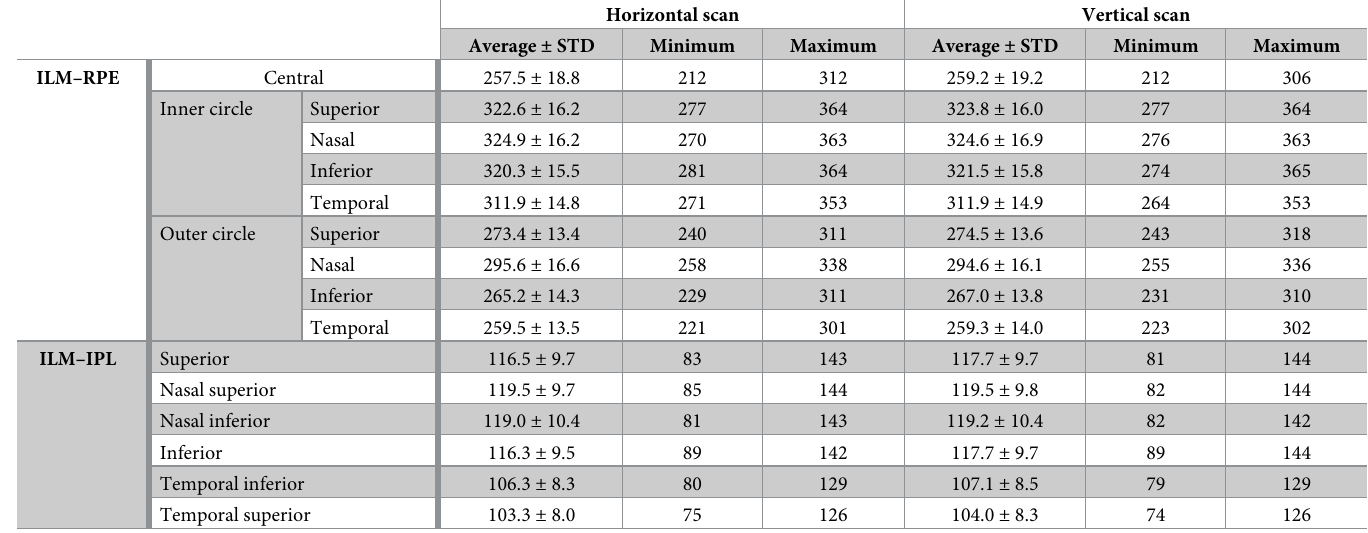
Table 1. Thickness values for different sectors from horizontal and vertical macular scans.